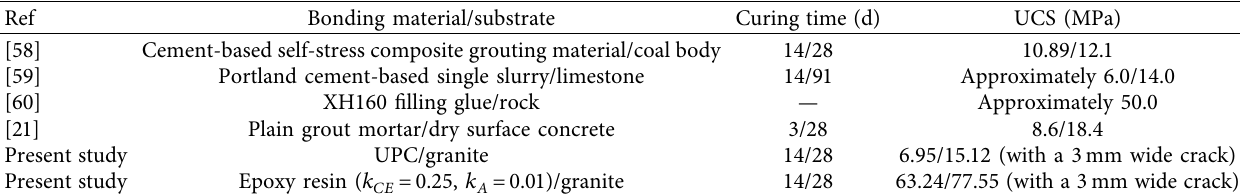
Table 2: UCS recovery listed in other